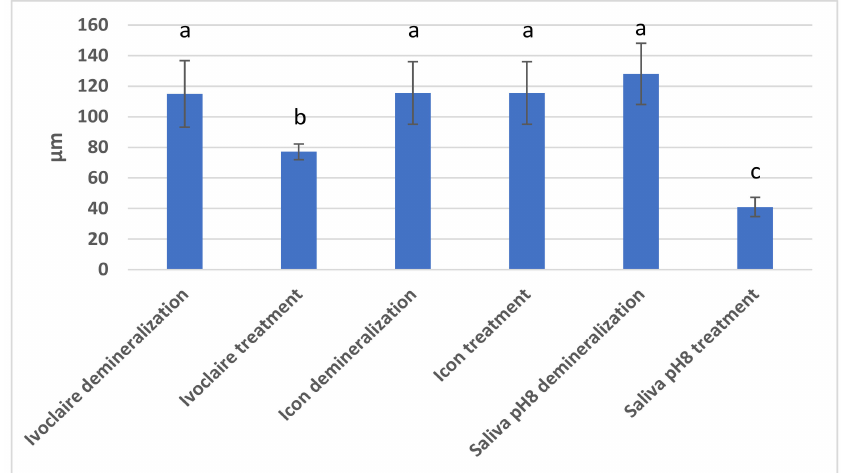
Figure 5. Demineralisation and Fluor Protector (Ivoclar Vivadent) treatment, resin infiltration treat- ment with Icon, (DMG Hamburg), and basic saliva pH treatment. Different letters indicate statistically significant differences p ≤ 0.05 (Duncan’s